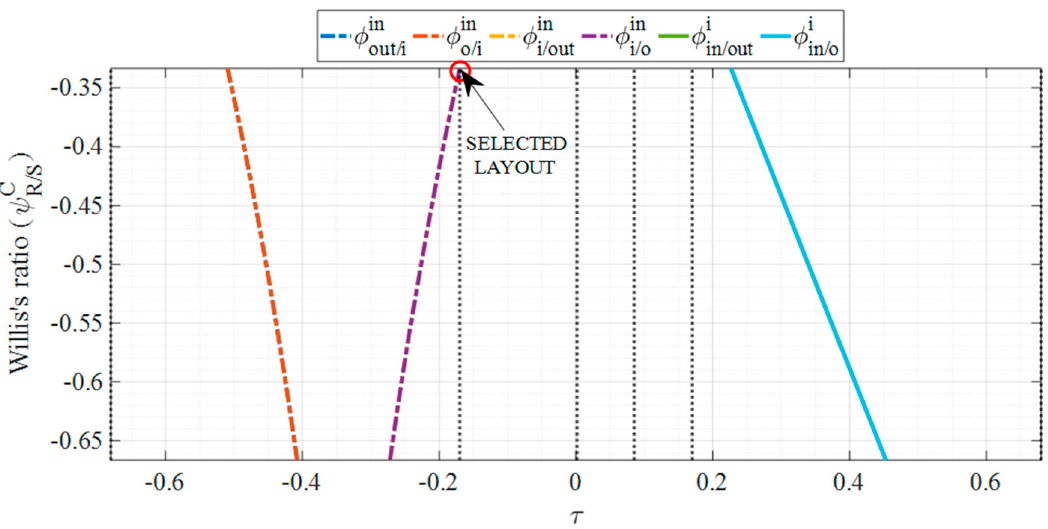
Figure 10. Design chart for PG synthesis and selected layout with ICE working at 1400 rpm and 1045 Nm.